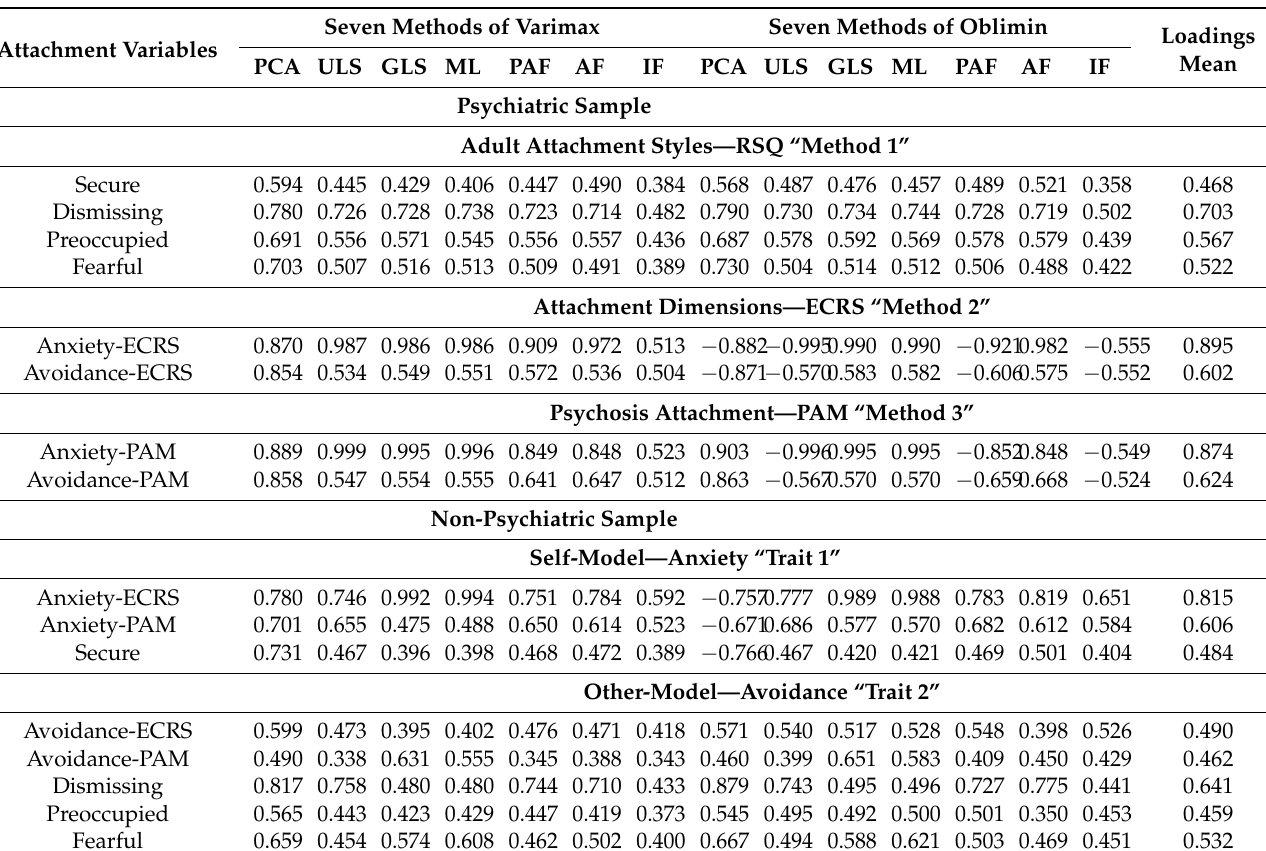
Table 3. Results of Various Rotation and Extraction Methods for Attachment Models Variables and their Factor Loadings